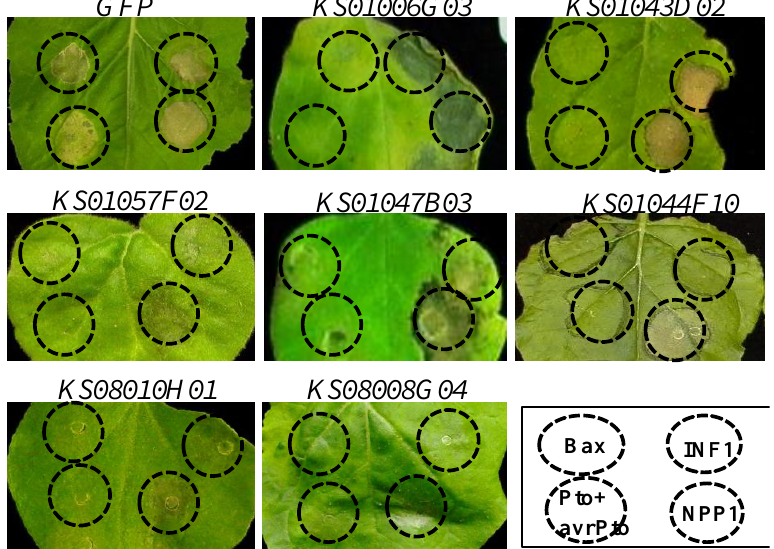
Figure 3. Comparison of cell death induced by Bax, Pto-avrPto, INF1, and NPP1 in plants silenced with TRV -pepper ESTs. N. benthamiana plants were inoculated with the indicated pepper TRV clones. After three weeks, upper leaves were exposed to Bax, Pto-avrPto, INF1, and NPP1, and images were taken three days